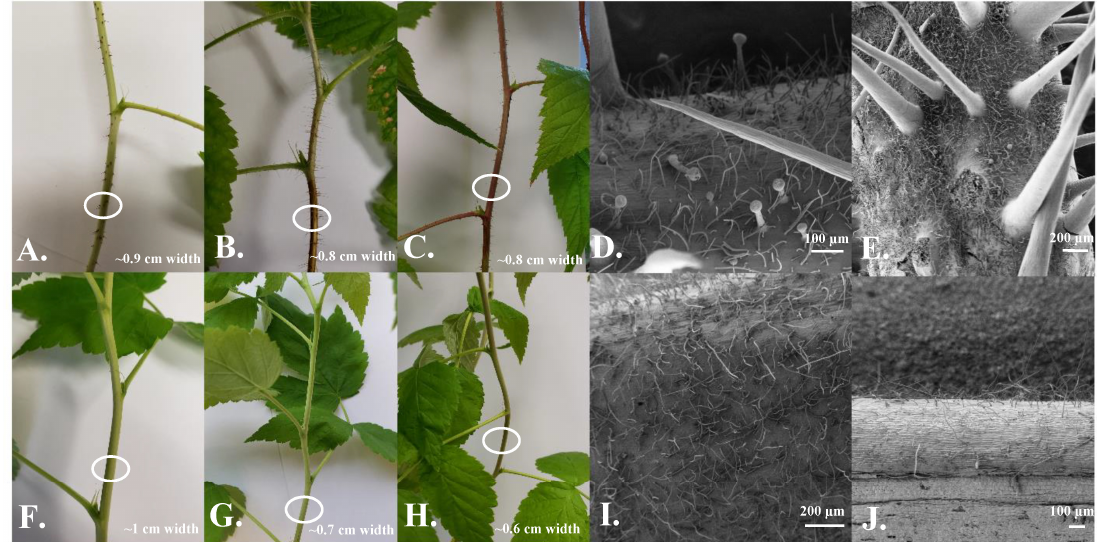
Figure 1. Photos showing prickles and trichomes on the surface of prickled and prickle-free Rubus idaeus L.: ( A – C ) prickled and ( F – H ) prickle-free. SEM micrographs showing ( D , E ) prickles, glandular trichomes and simple trichomes on prickled stems and ( I , J ) simple trichomes on prickle-free stems.